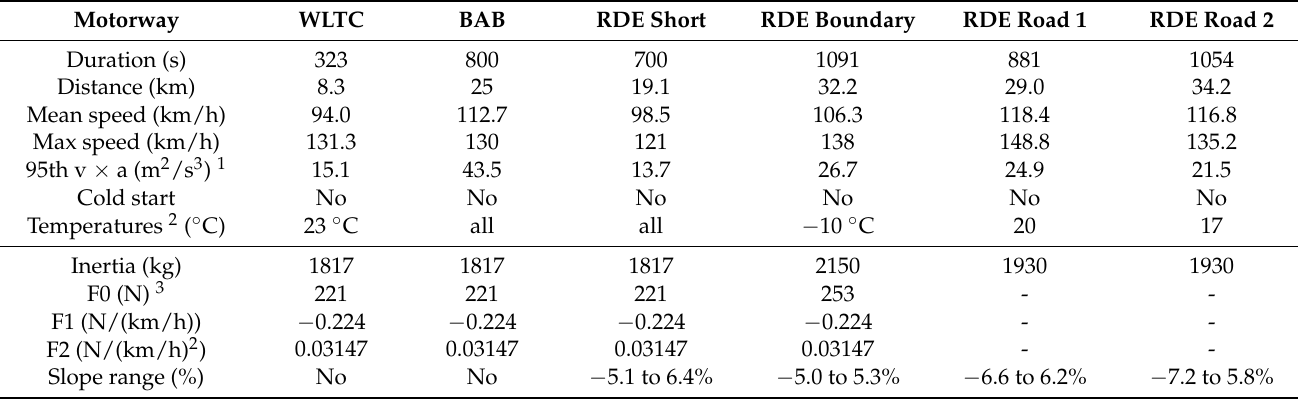
Table 3. Characteristics of the motorway cycle (BAB), the extra-high part of WLTC and the motorway parts of the RDE cycles. All tests conducted on the chassis dynamometer except RDE Road 1 and 2 which were done on the